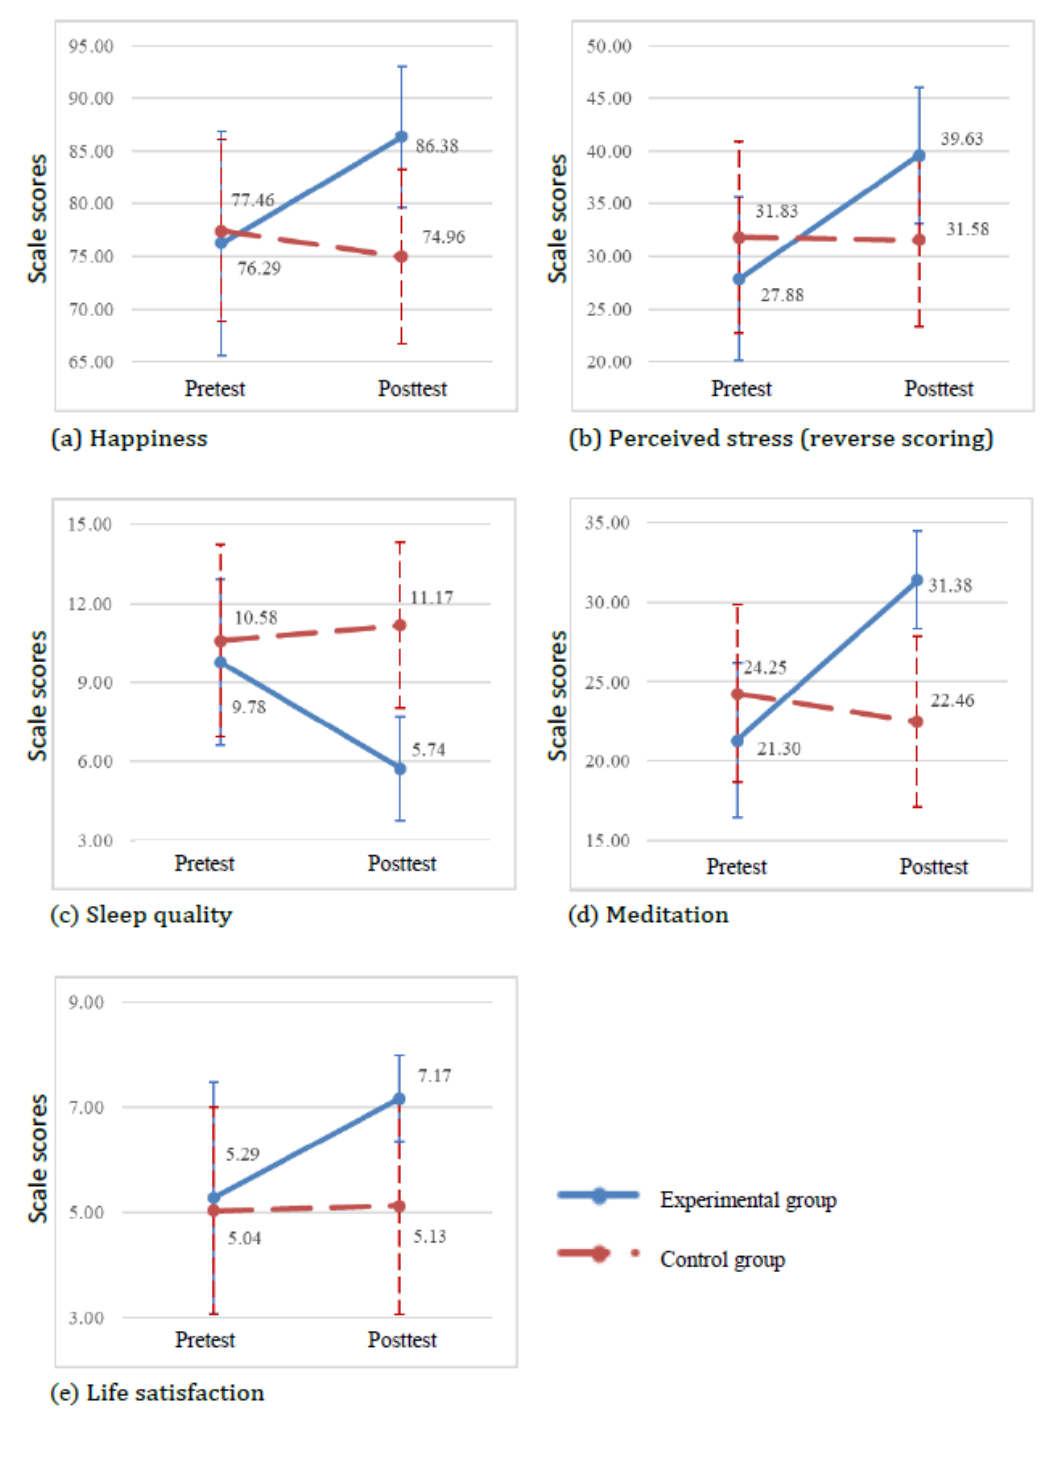
Figure 3. Changes in happiness, perceived stress, sleep quality, meditation, and life satisfaction between experimental and control